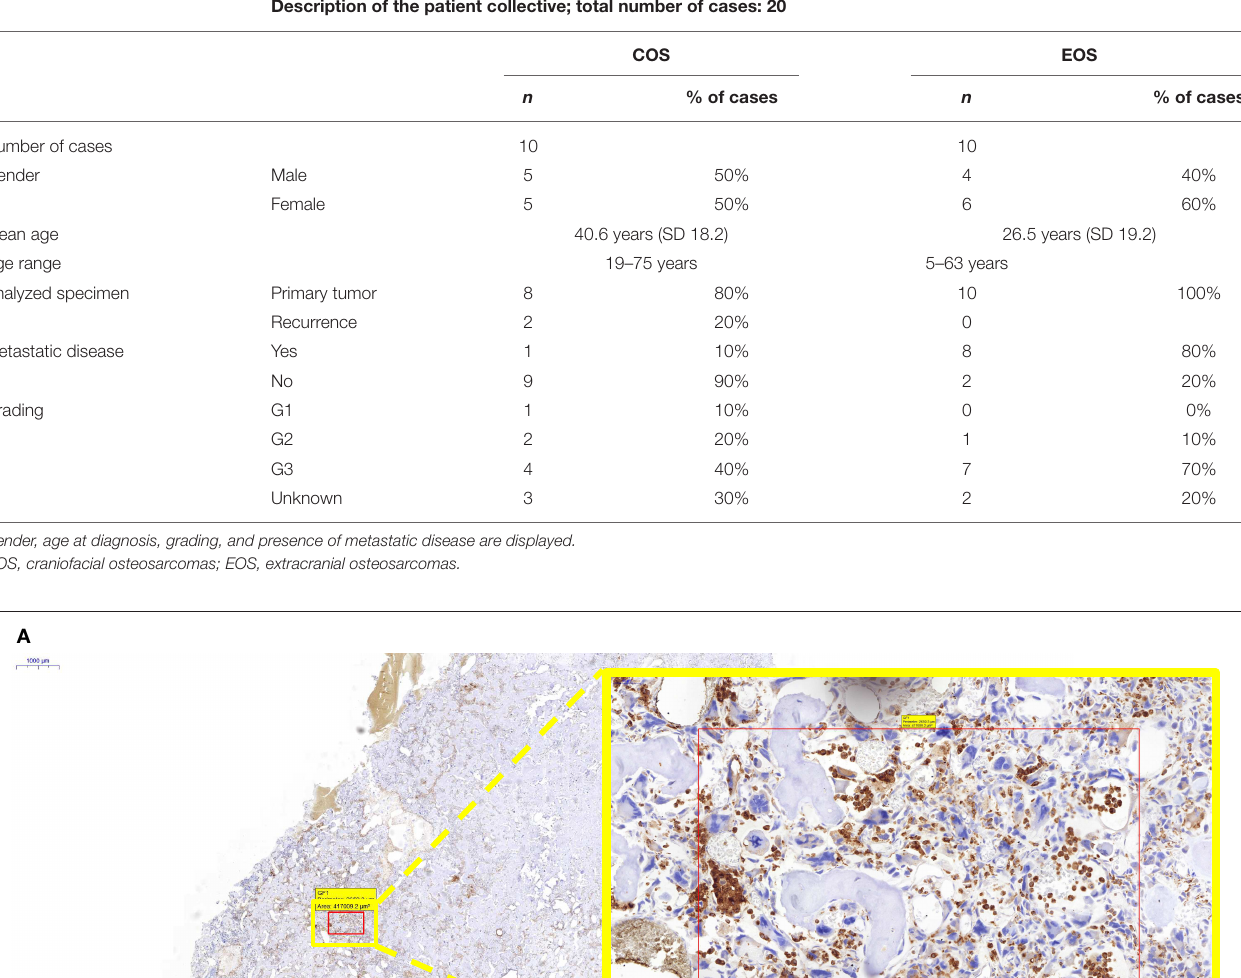
TABLE 1 | Demographic parameters of the patient